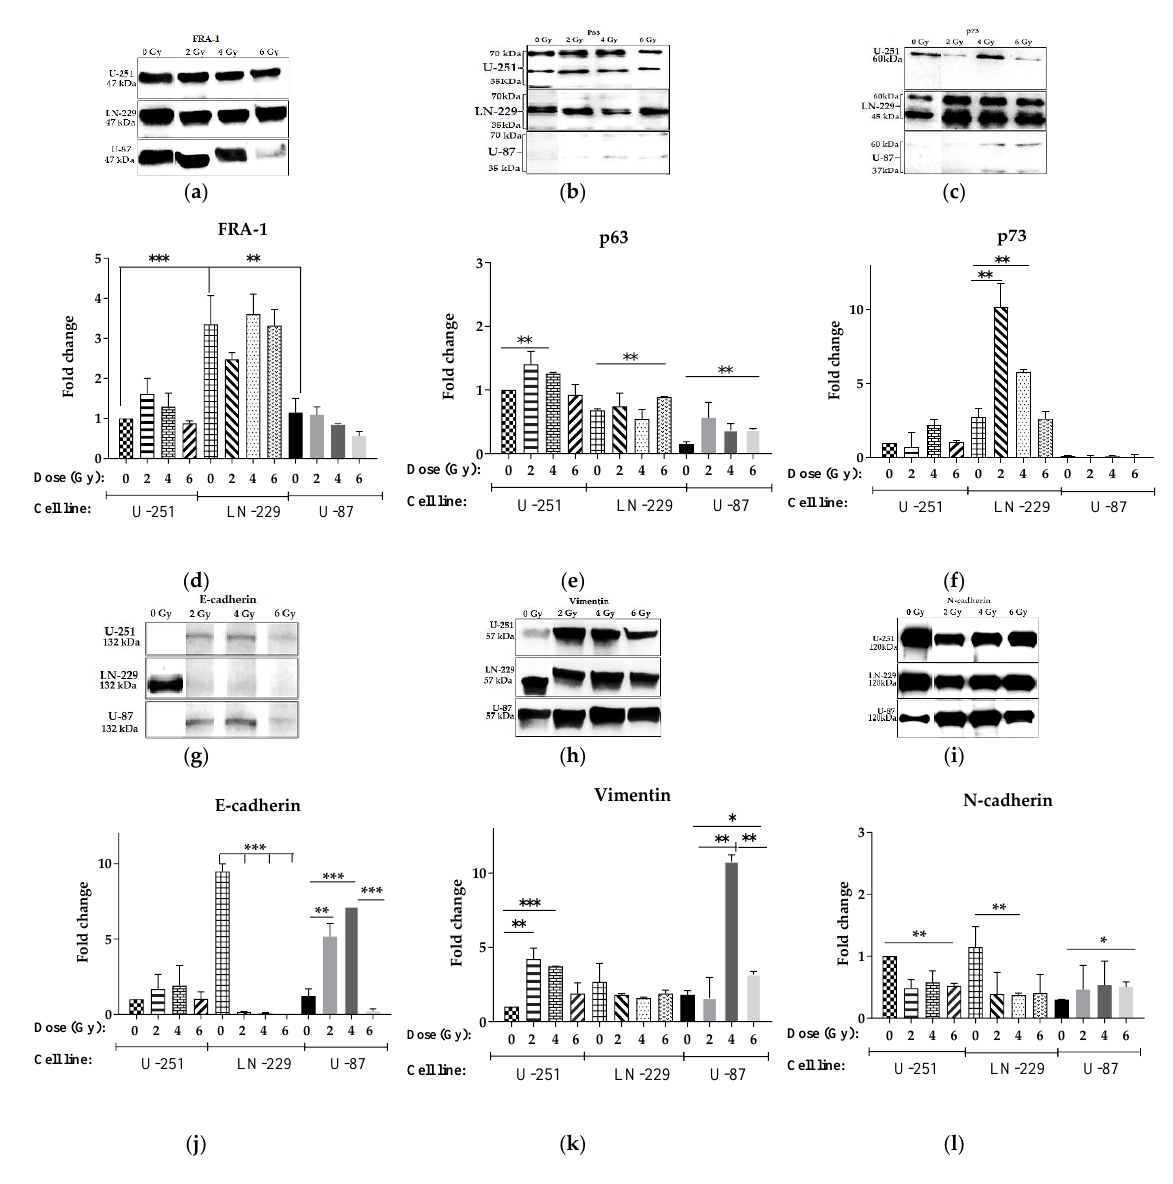
Figure 8. Semi-quantitative Western blot analysis of expression of EMT-related markers in control (non-irradiated, 0 Gy) cells vs. irradiated GBM cells 24 h after exposure to different doses of X-rays. Western blot of ( a ) FRA-1 protein, ( b ) p63, ( c ) p73, ( g ) E-cadherin, ( h ) vimentin, and ( i ) N-cadherin and quantification of ( d ) FRA-1 protein, ( e ) p63, ( f ) p73, ( j ) E-cadherin, ( k ) vimentin, and ( l ) N-cadherin expression. Data are means ± SEM of more than three independent experiments. * p ≤ 0.05, ** p ≤ 0.01, *** p ≤ 0.001.